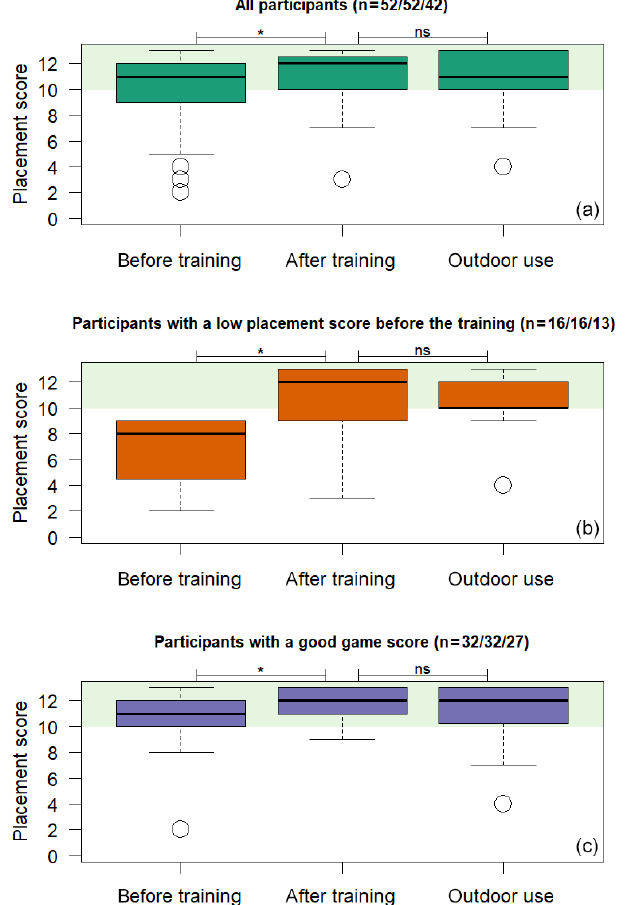
Figure 7. Box plots of the placement scores before the training (first task), after the training online (fourth task) and outdoors with the app (sixth task) for all participants (a) , for participants who had a low placement score before the training (b) and for participants who had a good game score (c) . There was a statistically signifi- cant difference in the placement scores before and after the training for all groups (indicated by ∗ ) and no statistically significant dif- ference between the computer-based task and the outdoor app task (indicated by “ns”) after the training based on the Wilcoxon test ( p< 0 . 05). The green shading indicates a good